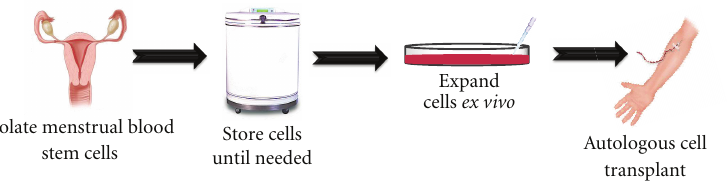
Figure 1: Isolation and transplantation of autologous menstrual blood-derived cells. Menstrual blood cells can be collected and stored prior to injury or the development of a neurodegenerative disease. At the time of injury, the cells can then be thawed and expanded ex vivo. Once the ideal number of cells has been reached, the autologous menstrual blood-derived cells can be transplanted into the patient.